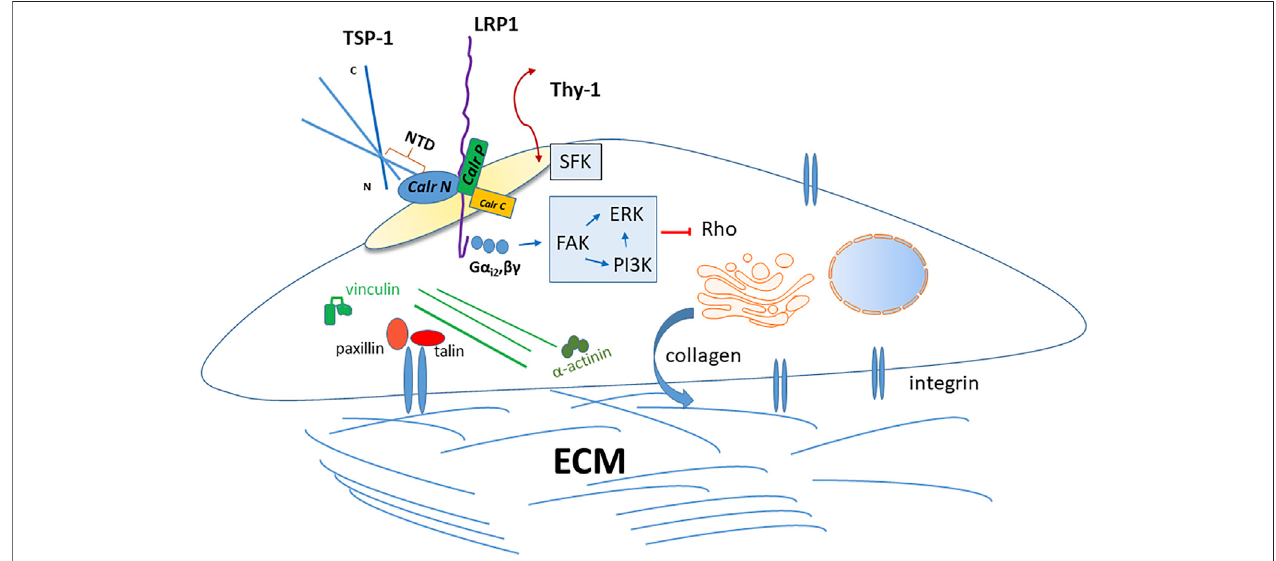
FIGURE2| Thrombospondin-1signalingthroughthecaleticulin-LRP1complex.ThesequencerepresentedbythehepIpeptide(aminoacids17 – 35)intheNTDof TSP-1 bindtotheN-terminaldomain ofcalreticulinatthecellsurface.TheTSP-1bindingsitehasbeenlocalizedtoaminoacids19 – 26incalreticulin.BindingofTSP-1to calreticulin induces altered interactions between the calreticulin N and P domains to expose the putative LRP1 binding site and increase association of calreticulin with LRP1 and activation of downstream signaling. This occurs in lipids rafts. The GPI-linked protein, Thy-1, must also be present in lipid rafts and it activates Src family kinases, which are necessary for TSP-1 signaling through calreticulin/LRP-1, although direct interactions of Thy-1 with this complexhave not been demonstrated. TSP- 1-calreticulin engagement of LRP1 induces association with the G α i2 heterotrimeric G protein subunit. This activates downstream FAK that induces PI3K and ERK signaling, culminating in a transient downregulation of Rho kinase activity. In fi broblasts and endothelial cells, TSP-1 signaling through calreticulin/LRP1 induces focal adhesion disassembly with cytoskeletal reorganization accompanied by loss of vinculin and α -actinin from integrin-talin clusters. This state of intermediate adhesion renders cells more motile and resistant to anoikis in a PI3K-dependent manner. In vivo expression of the secreted TSP-1 calreticulin binding sequence in a model of the foreign body response increases pericapsular collagen density and increased collagen matrix assembly in vitro , similarly in a PI3K-dependent